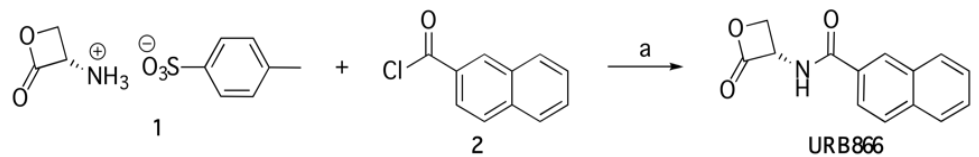
◦ C, 0.5 h, then room temperature, 2 h. a Reagents and conditions: (a) Et Figure 1. a Reagents and conditions: ( a ) Et 3 N, CH 2 Cl 2 , 0 °C, 0.5 h, then room temperature, 2 h. Figure 1. 3 N, CH 2 Cl 2 , 0 Melting points were determined on a Büchi B-540 capillary melting point